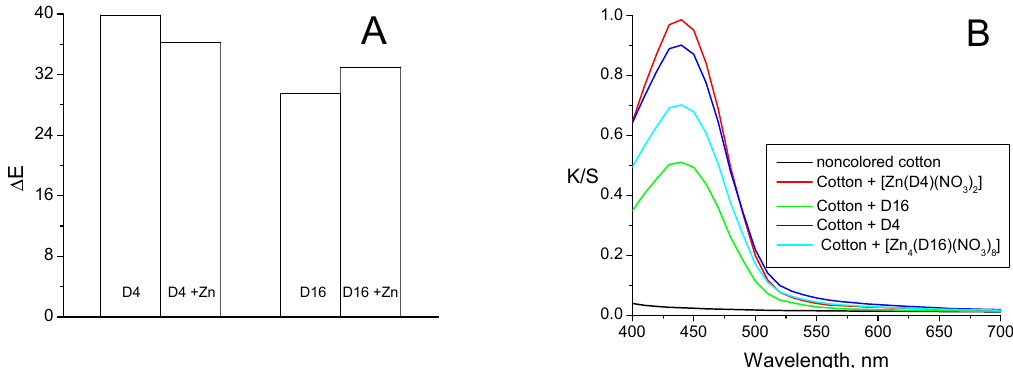
Figure 2. The color difference Δ E ( A ) and K/S ( B ) of cotton fabric treated with D4 and D16 and their Zn(II) complexes.